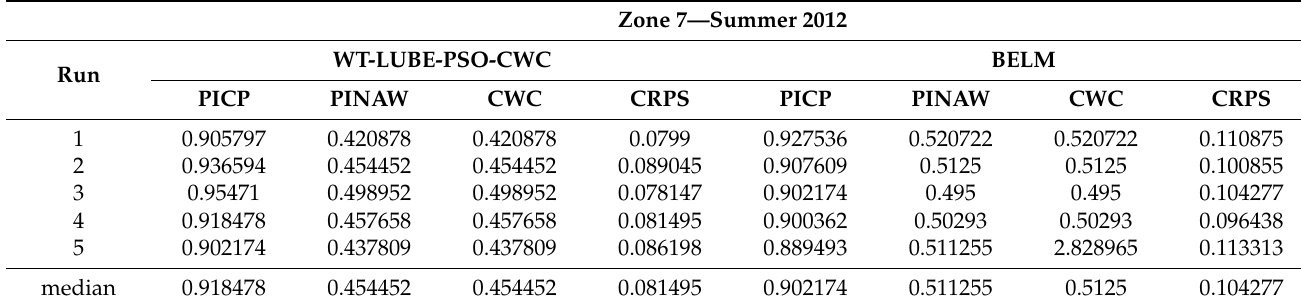
Table 7. Results of the evaluation of 5 training sessions of WT-LUBE-PSO-CWC and BELM models in zone 7 for summer 2012 at the 0.9 confidence level.